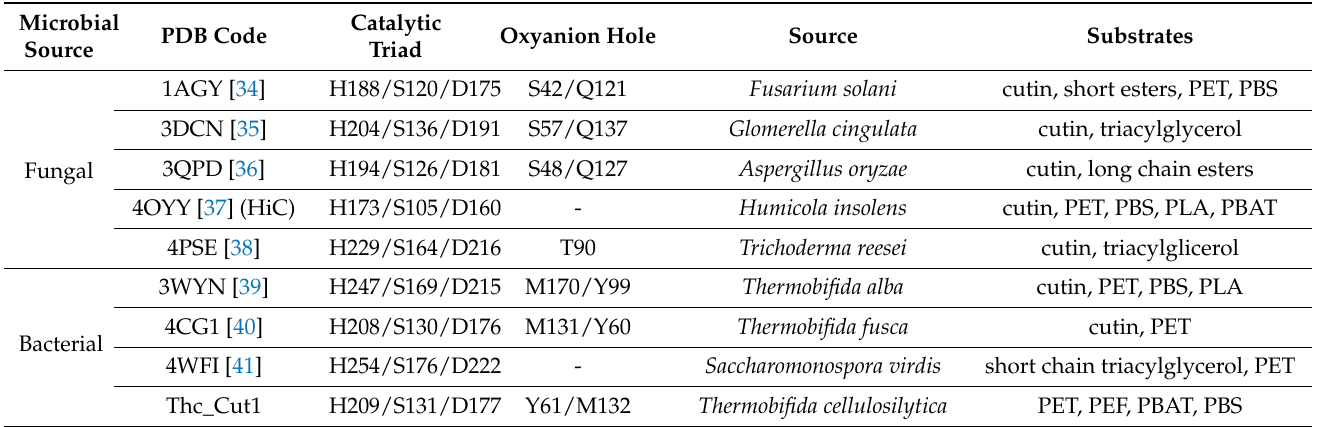
Table 1. Cutinase enzymes analyzed in the present study and residues composing their catalytic machinery, which were also used for cutinases structural